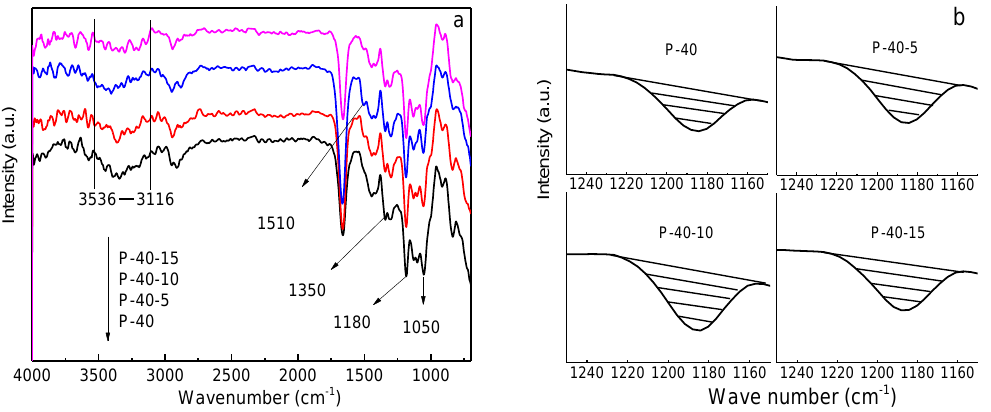
Figure 5. FTIR spectra of P-40, P-40-5, P-40-10, and P-40-15 films in the ranges of ( a ) 4000–700 cm − 1 and ( b ) 1250–1150 cm − 1 .